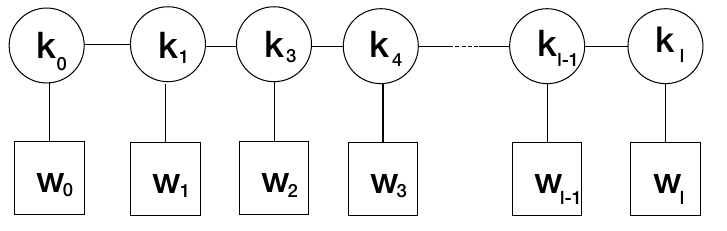
Figure 2 . The Kronheimer-Nakajima quiver for a fractional U( N ) instanton on C 2 = Z n , with KN vector ~k = ( k 0 ; k 1 ; k 2 ; : : : ; k l ; 0 ; : : : ; 0) and monodromy vector ~w = ( w 0 ; w 1 ; w 2 ; : : : ; w l ; 0 ; : : : ;